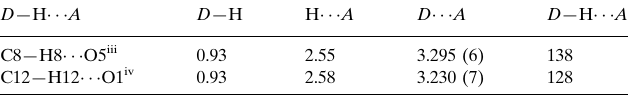
Hydrogen-bond geometry (A ˚ , (cid:2)